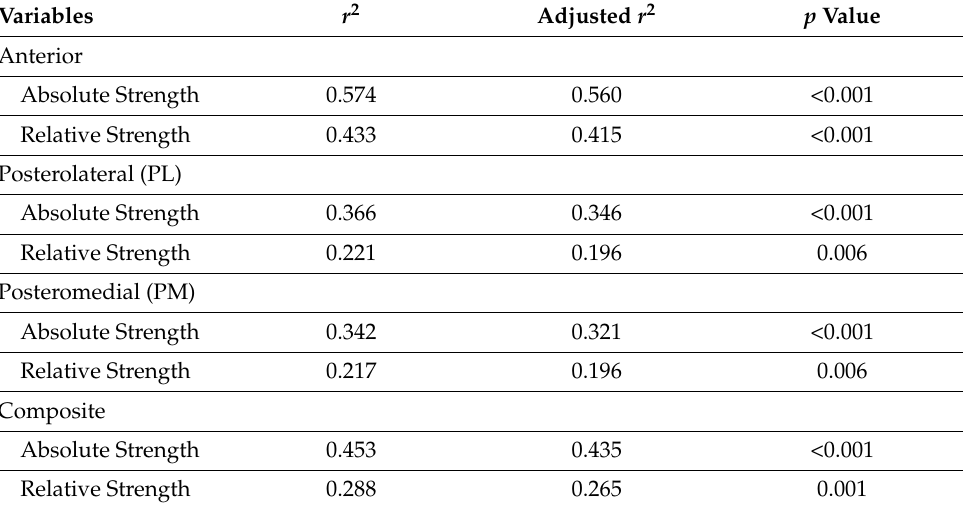
Table 3. Results of the linear regression analysis for the unilateral leg extension strength and the results of the Y Balance